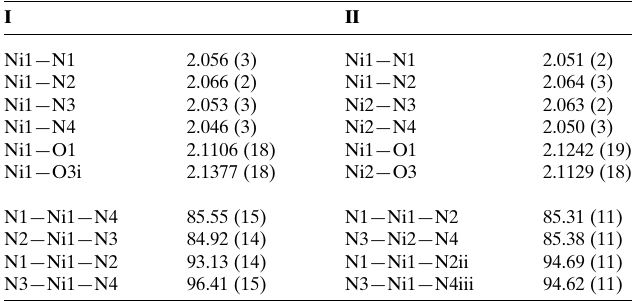
Table 1 Selected geometric parameters (A˚ , (cid:4)